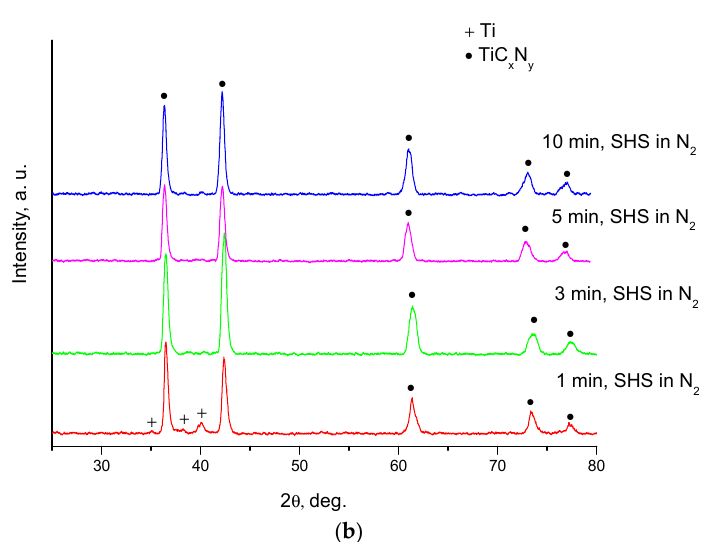
Figure 7. XRD patterns of the product of SHS in the Ti+0.3C mixture ball-milled for 5 min, combustion in argon ( a ), ball-milled for 1, 3, 5 and 10 min, combustion in nitrogen ( b ). The combustion rate of the Ti+0.3C mixtures changes with the milling time. As the milling time increases from 1 to 7 min, the combustion rate increases from 2.3 ± 0.2 to 11 ± 1 mm s − 1 . Combustion of powders ball-milled for 1–4 min is accompanied by the ejection of hot particles from the combustion wave. The SHS products obtained in nitrogen using mixtures milled for 1–4 min are composed of titanium carbonitride and metallic titanium. The intensities of the titanium lines on the XRD patterns of the combustion products obtained in nitrogen decrease as the milling time increases; the product obtained from a mixture ball-milled for 5 min is a single-phase carbonitride (Figure 7b). This sample shows no ejection of particles during the combustion. Samples milled for 1–7 min show similar thermograms. The duration of the nitridation stage decreases as the milling time of the mixtures increases; in the sample milled for 7 min, the nitridation occurs within 1 min. The mixture milled for 10 min demonstrates a combustion rate of 8 ± 1 mm s − 1 . The product of SHS conducted in this mixture is single-phase.